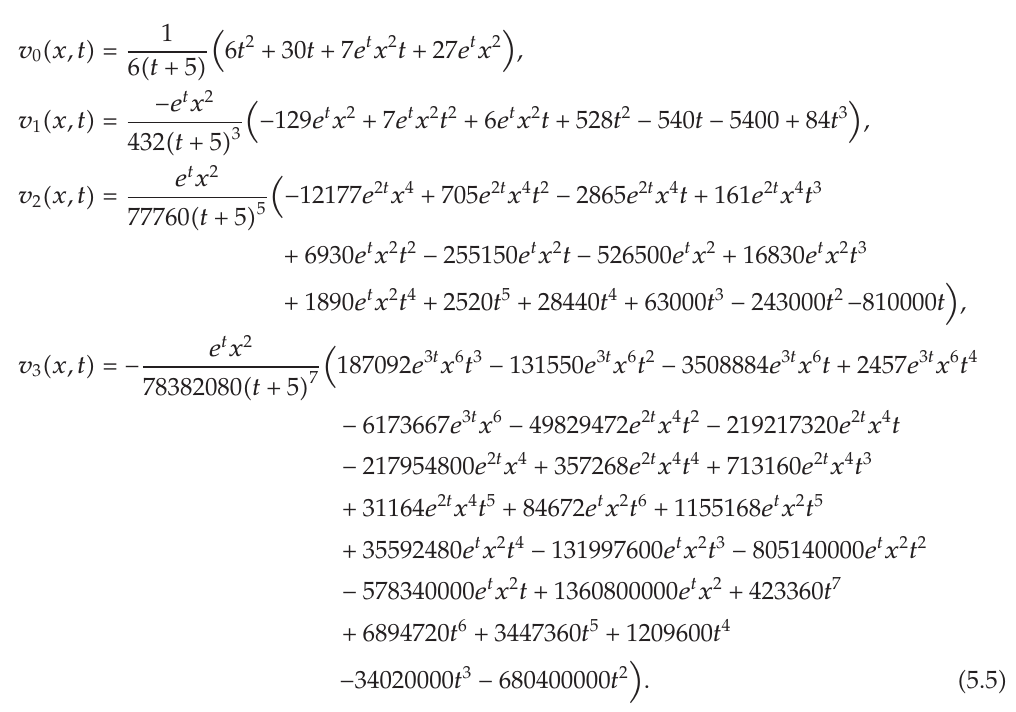
By substituting (cid:3) 3.5 (cid:4) into the above equation, and equating the terms with identical powers of p, we have